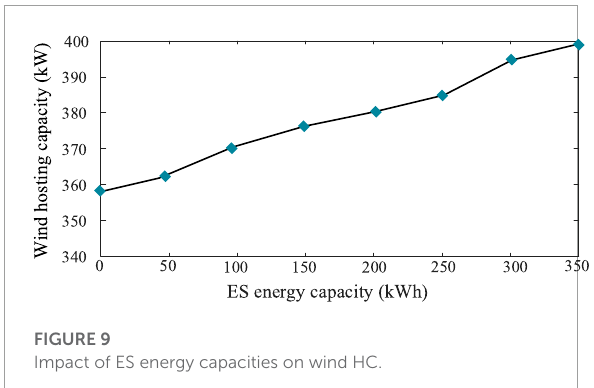
FIGURE 9 Impact of ES energy capacities on wind